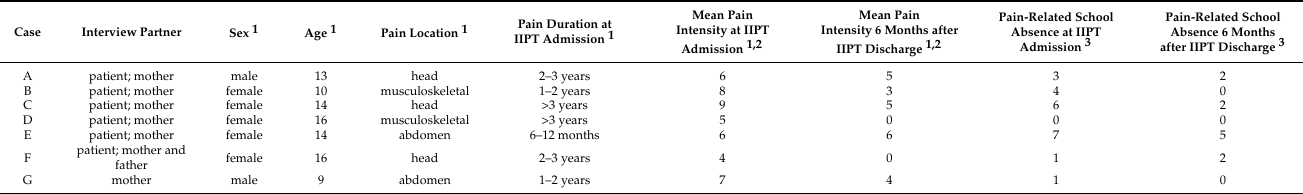
Table 1. Characteristics of the patients.